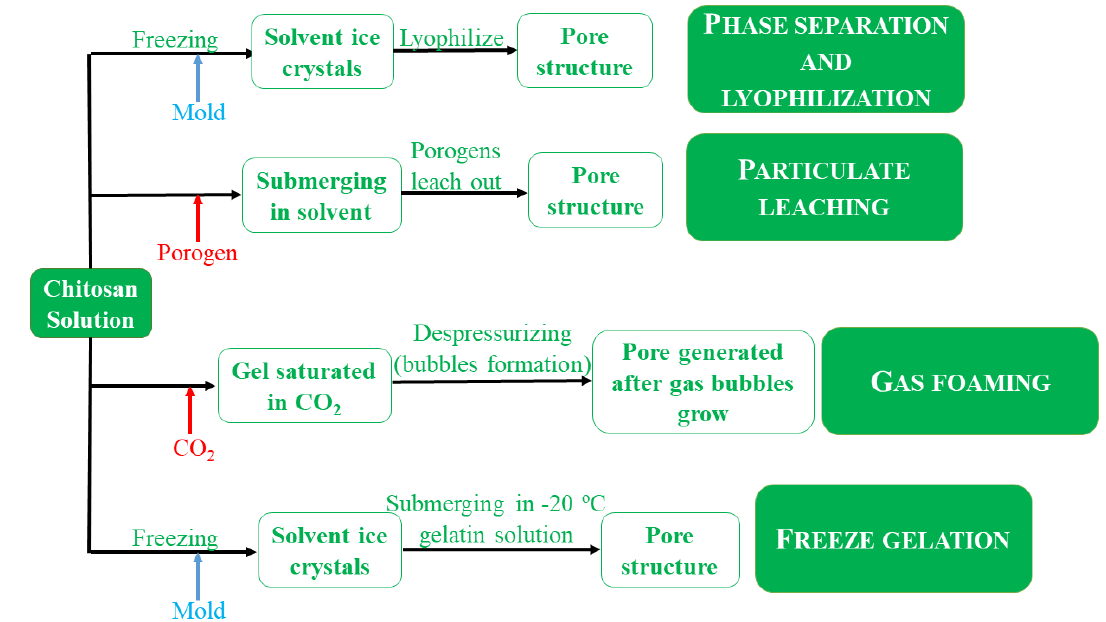
Figure 10. Different methodologies to synthesize three-dimensional chitosan scaffolds. Figure 10. Di ff erent methodologies to synthesize three-dimensional chitosan sca ff